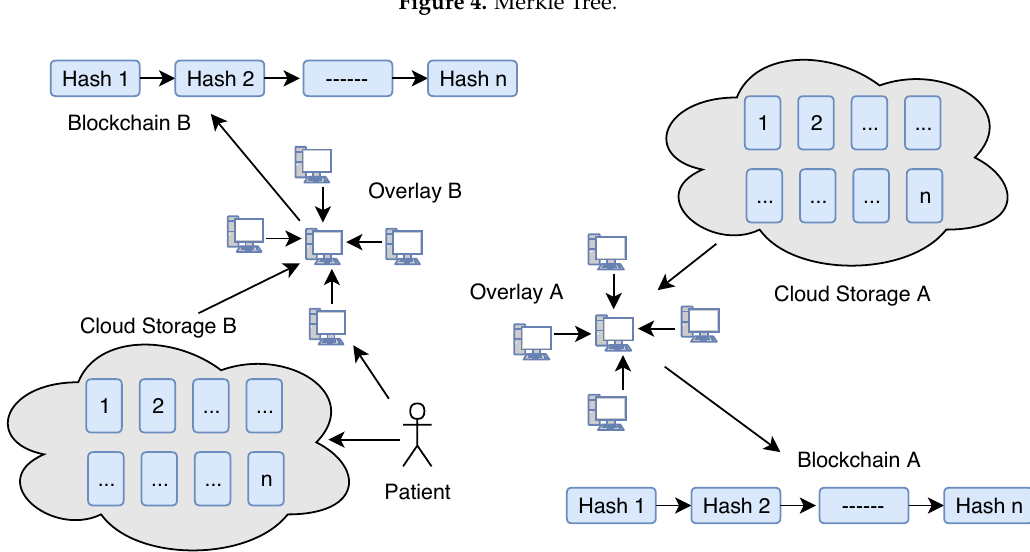
Figure 4. Merkle Tree.